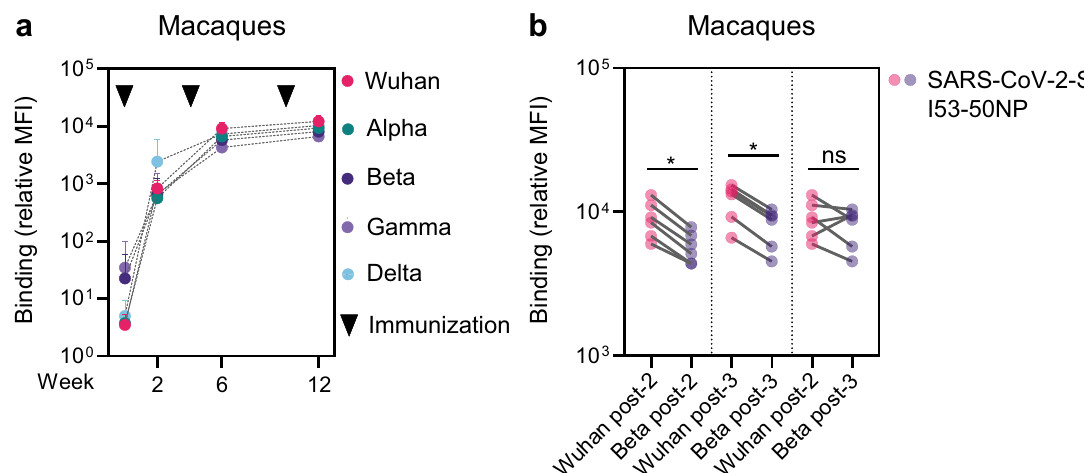
Fig. 2 Antibody binding responses against VOC in cynomolgus macaques after one two and three vaccinations with Wuhan-based Spike vaccine. a Longitudinal analysis of Ab binding to Wuhan S and VOC Alpha, Beta, Gamma, and Delta in macaques. Datapoints represent mean relative MFIs, error bars indicate SD. b Paired comparisons of Ab binding to Wuhan S and Beta S two weeks after the second and third vaccination, and to Wuhan S two weeks after the second vaccination and Beta S two weeks after the third vaccination. The relative MFIs between variants were compared using the Wilcoxon test (* P <